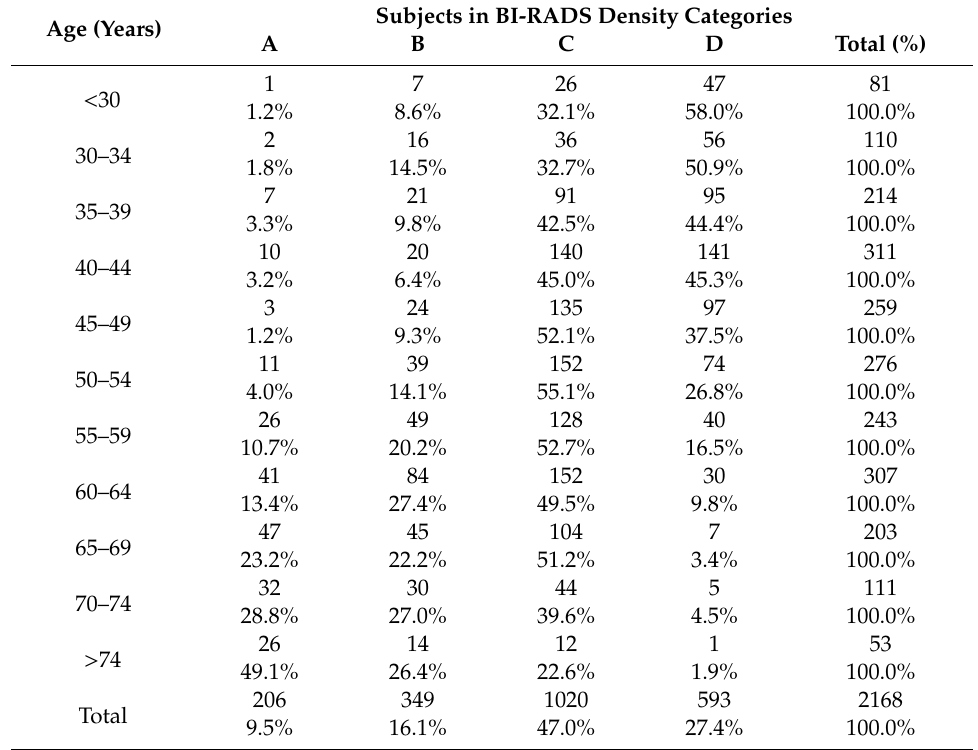
Table 2. Distribution by age group of mammographic density according to the 5th edition Breast Imaging Reporting and Data System (BI-RADS)